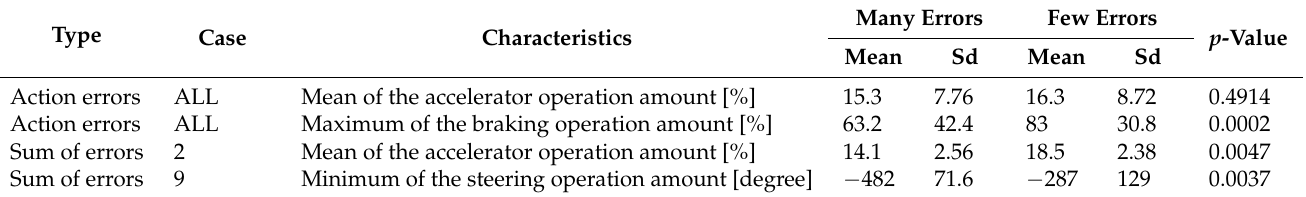
Table 5. Characteristics of few error and many error groups when the subject drove on the route with a driving simulator.